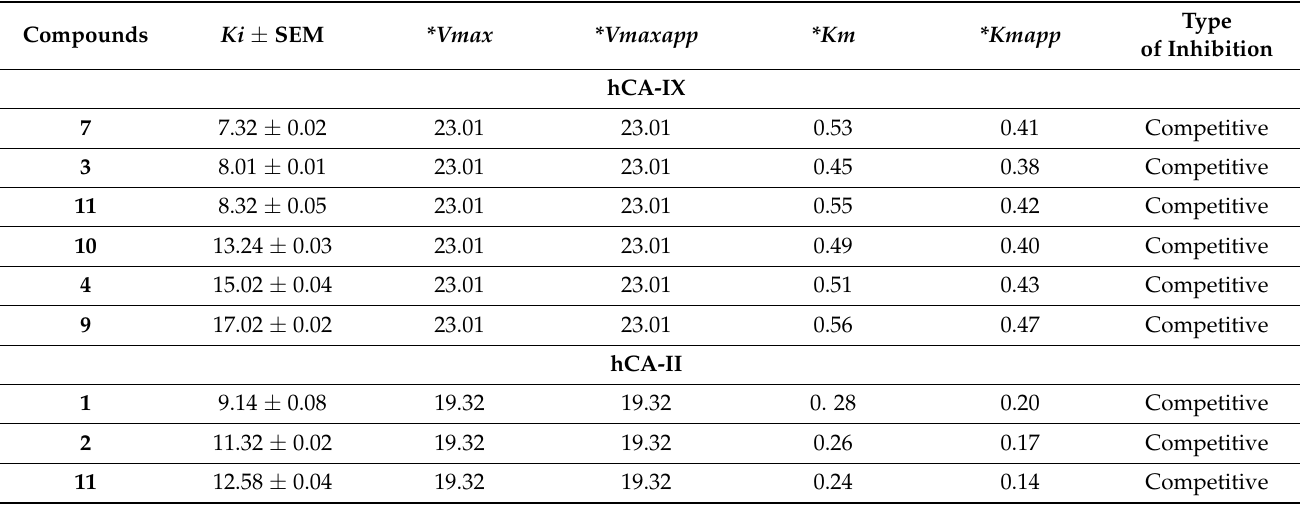
Table 2. Kinetic results of potent active